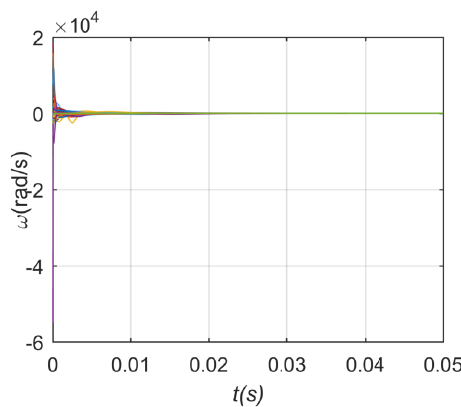
Figure 18. Frequency stabilization process of directed network in case 2.